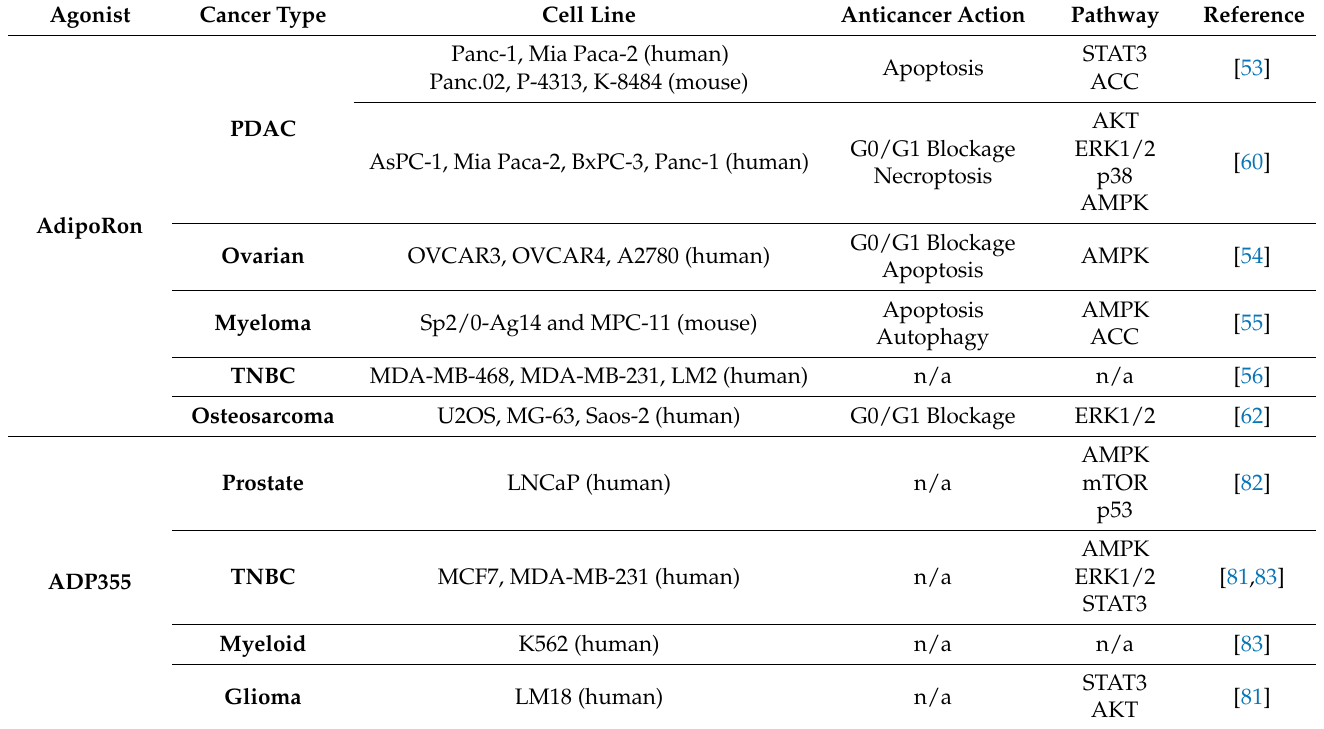
Table 1. Adiponectin receptor agonists related findings in cancer